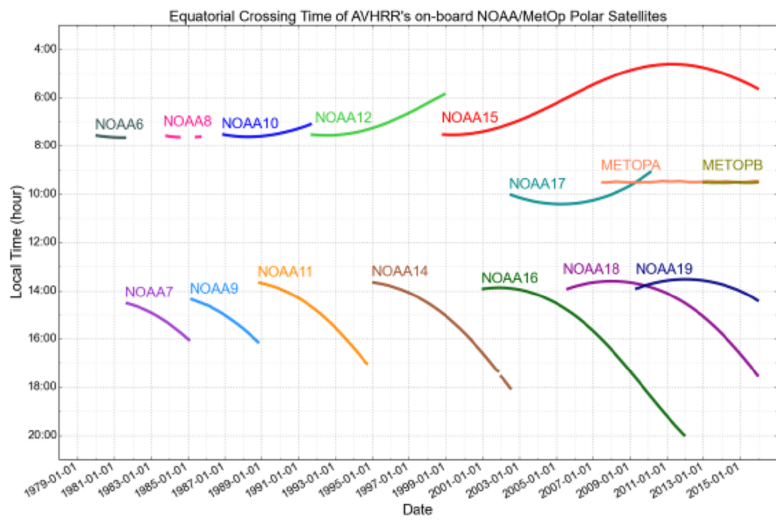
Figure 1. Equator Crossing Time (ECT) for the different NOAA and METOP satellites used in CLARA-A3. Figure taken from